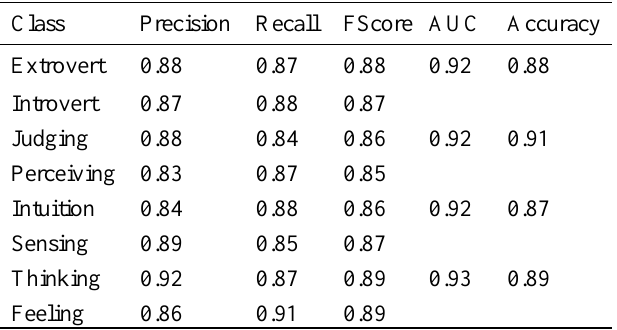
Random forest result with SMOTE